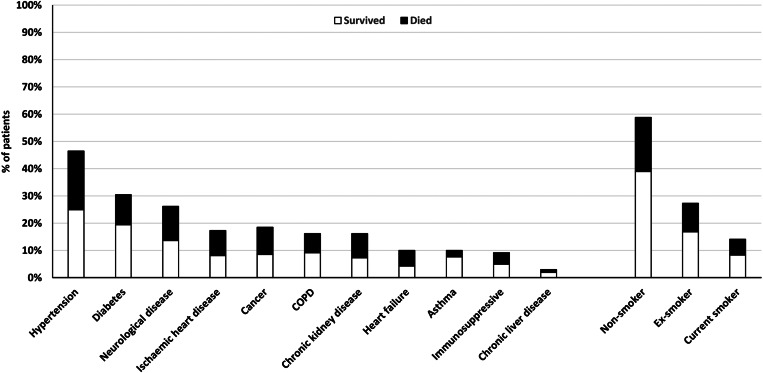
Comorbidities of patients admitted with Covid-19 to Royal Oldham Hospital, UK stratified by survival to 30 days post-discharge.